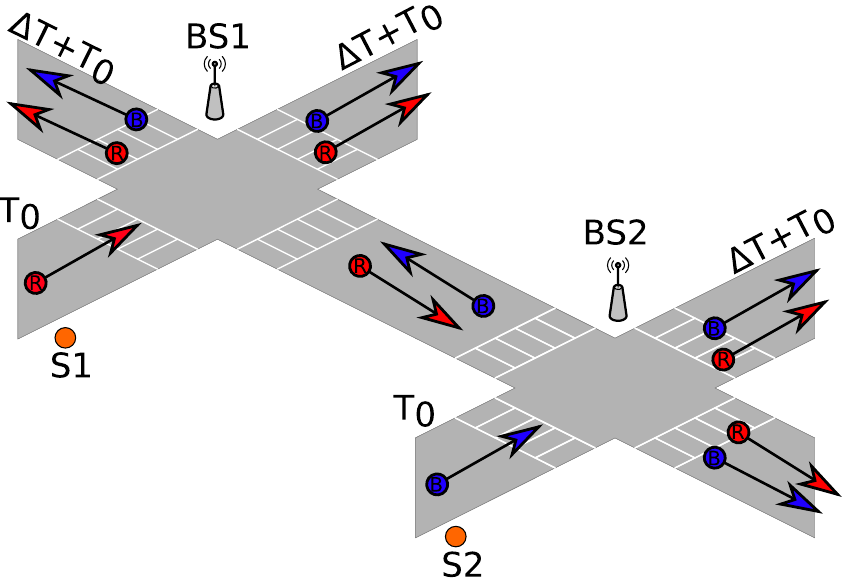
Figure 6. A simple scenario of the proposed traffic